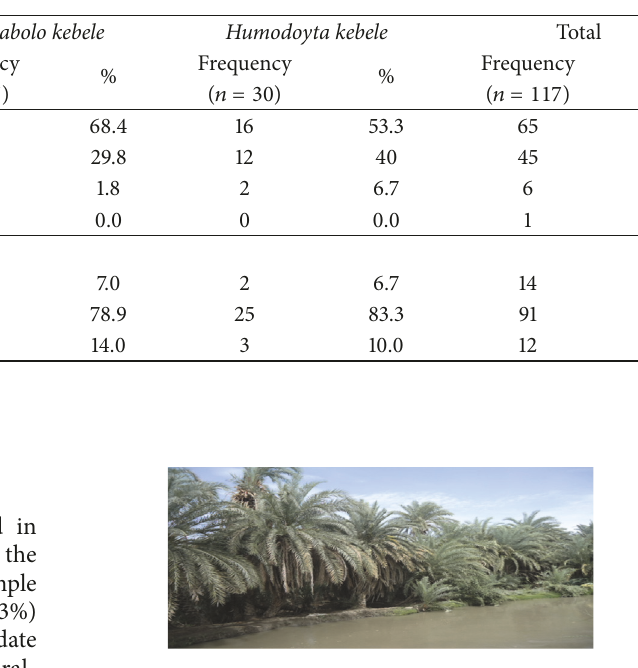
Figure 2: Date palm trees grown at Awash River bank in Alassabolo kebele of Afambo District (Photo taken during observation of the production areas,